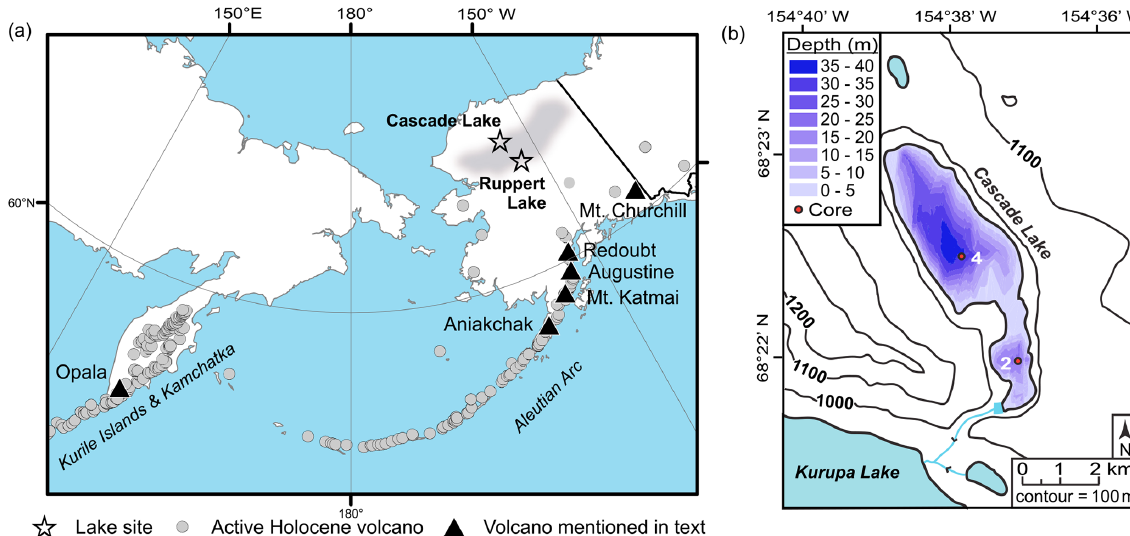
Figure 1. Location map showing Cascade Lake, coring sites, and other relevant locations and volcanoes mentioned in the text. Grey circles: active Holocene volcanoes (Global Volcanism Program, 2013); black triangles: volcanic sources mentioned in the text; grey shading: Brooks Range; star outlines: lakes mentioned in the